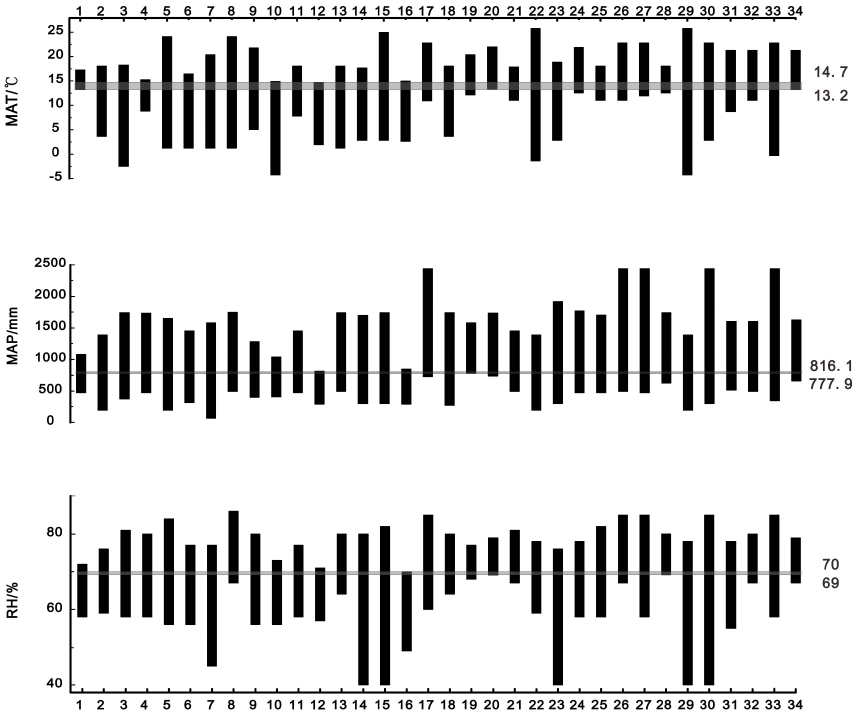
Fig. 6. Coexistence intervals for the Dadiwan section. 1. Picea brachytyla ; 2. Abies sp.; 3. Alnus sp.; 4. Ostrya sp.; 5. Betula sp.; 6. Corylus sp.; 7. Ulmus sp.; 8. Acer sp.; 9. Castanea sp.; 10. Quercus mongolica ; 11. Quercus aliena ; 12. Sorbus pohuashanensis ; 13. Juglans sp.; 14. Tilia sp.; 15. Alangium sp.; 16. Armeniaca sibirica ; 17. Firmiana sp.; 18. Prunus sp.; 19. Gymnocladus chinensis ; 20. Xylosma racemosum ; 21. Eucommia ulmoides ; 22. Lonicera sp.; 23. Toxicodendron sp.; 24. Liquidambar formosana ; 25. Cercidiphyllum japonicum ; 26. Ehretia sp.; 27. Cyclobalanopsis sp.; 28. Fagus sp.; 29. Vaccinium sp.; 30. Osmanthus fragrans ; 31. Picrasma sp.; 32. Phyllostachys sp.; 33. Fargesia sp.; 34. Indocalamus